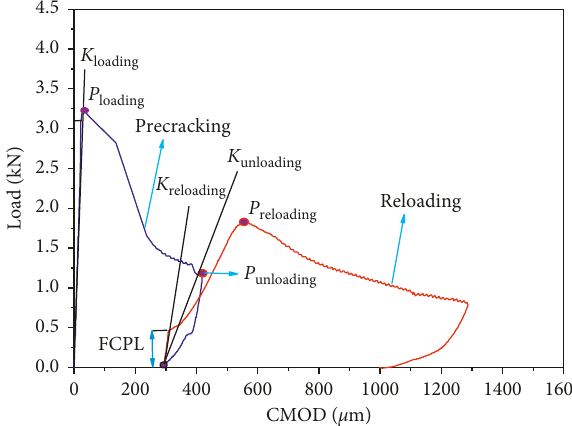
Figure 3: Load versus CMOD response during 3 PBT: (blue) precracking curve and (red) reloading curve after exposure du- ration. Definitions of quantities used in calculation of self-healing indices are also